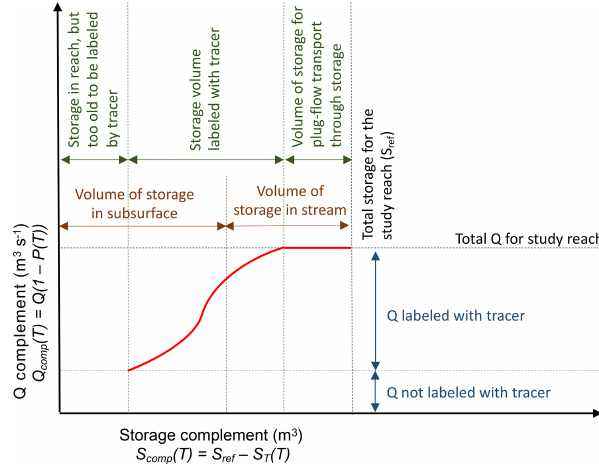
Figure 2. Graphical representation and interpretation the SAS func- tion. Note that the volume of storage in the stream vs. subsurface (orange above) is independent of the SAS analysis and is provided here as an example of integrating the SAS metrics with other knowl- edge about the